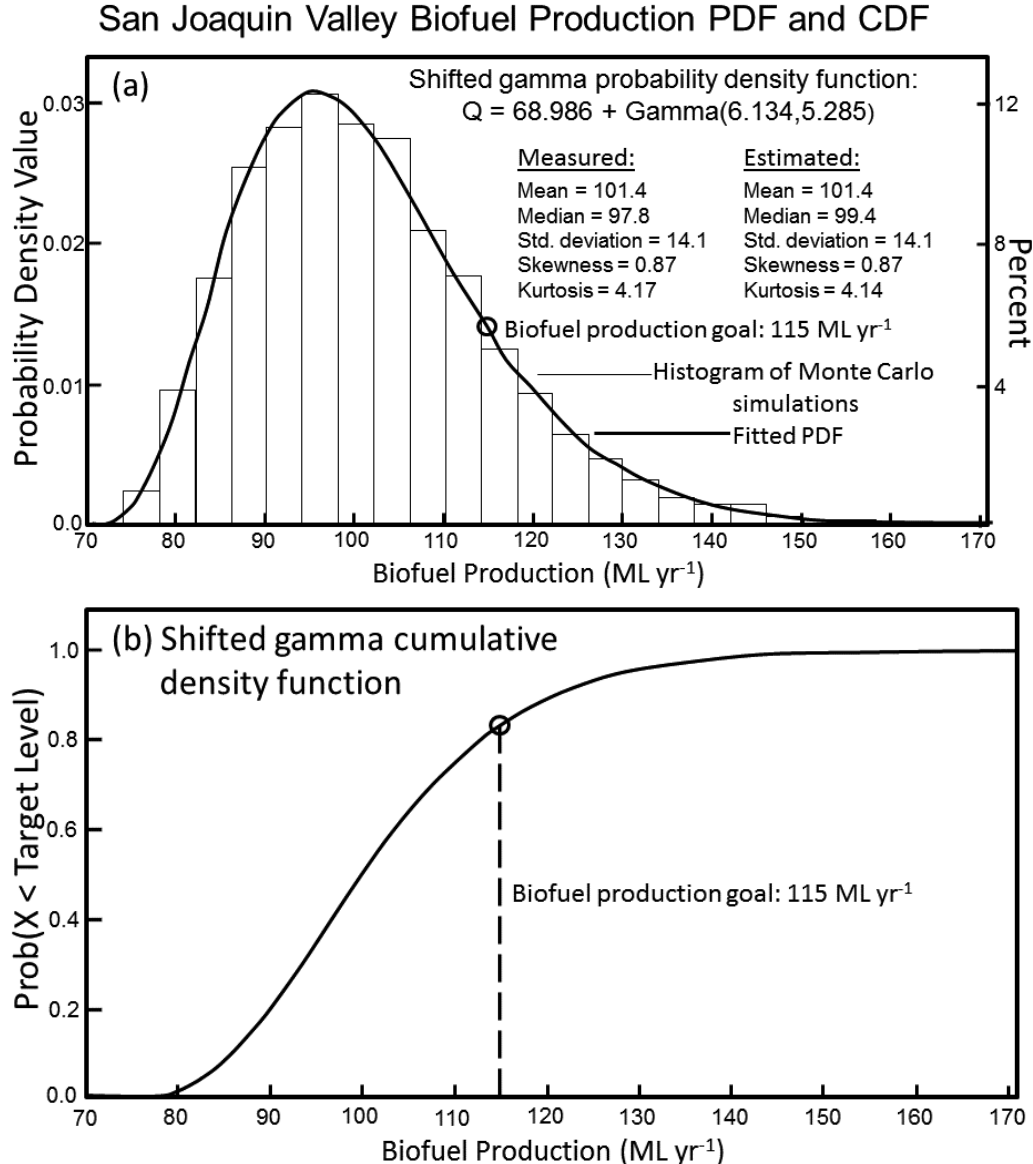
Figure 8. Biofuel production ( a ) histogram of Monte Carlo simulations and associated probability density function (PDF) and ( b ) cumulative density function (CDF) for Ida Gold mustard oilseed from San Joaquin Valley salt-affected soils (i.e., soils with salinity of > 4 dS m −1 ) based on 10,000 Monte Carlo simulations.